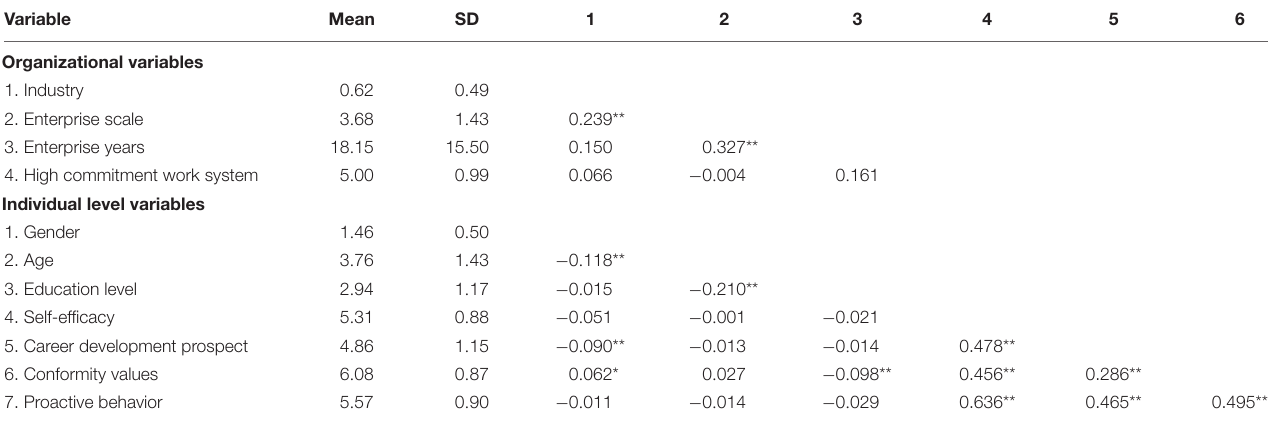
TABLE 1 | Means, standard deviations, and correlations among study variables. Variable Mean